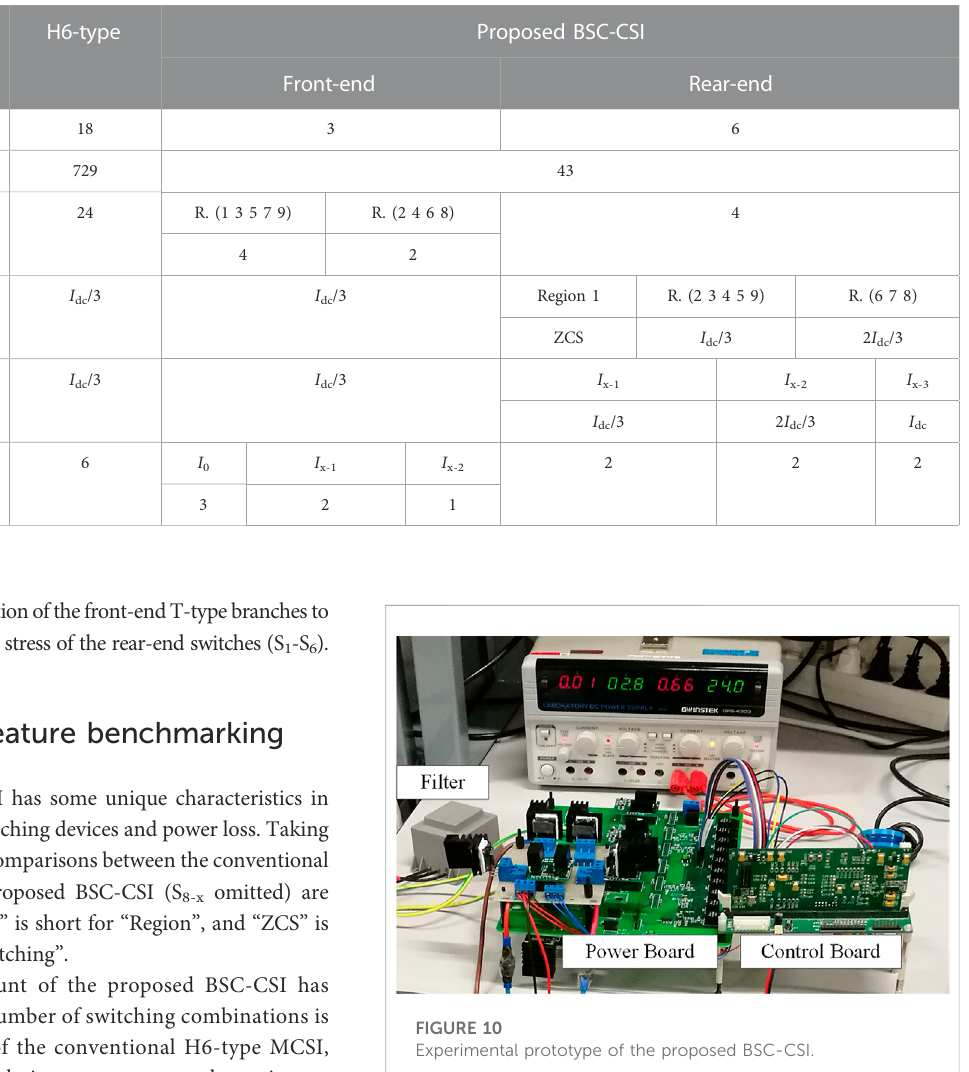
TABLE 3 Comparisons between the H6-type MCSI and the proposed BSC-CSI (7-level).